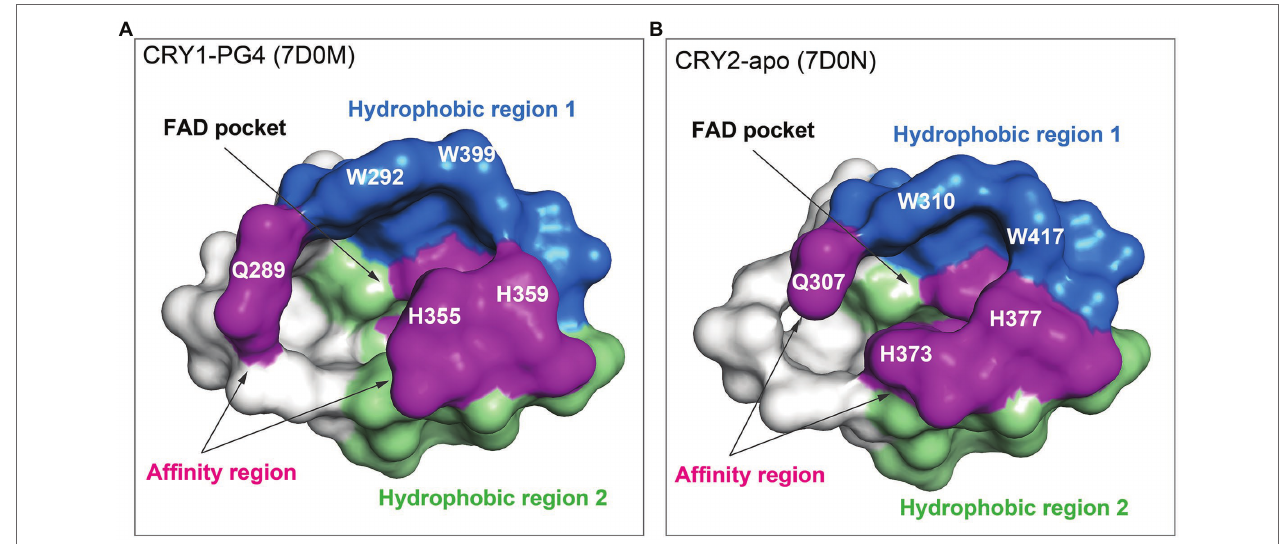
FIGURE 3 | FAD pocket surfaces in CRY1 and CRY2. The FAD pocket can be divided into three subregions: Hydrophobic region 1 (blue), the affinity region (magenta), and hydrophobic region 2 (green). Pockets are shown for CRY1-PG4 [the PG4 molecule (not shown) was present in the crystallization buffer and bound non-specifically in the FAD pocket; PDB ID: 7D0M] (A) and CRY2-apo (7D0N) (B) .